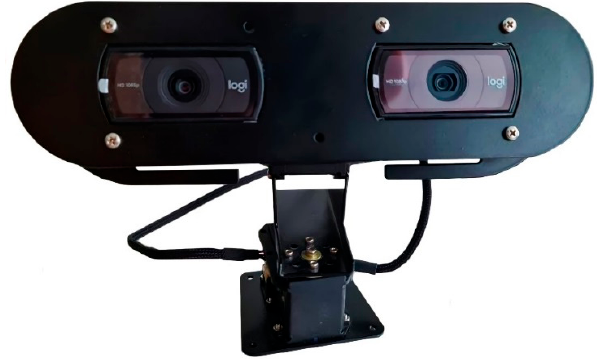
Figure 6. Stereo camera of the apple fruit identification system.